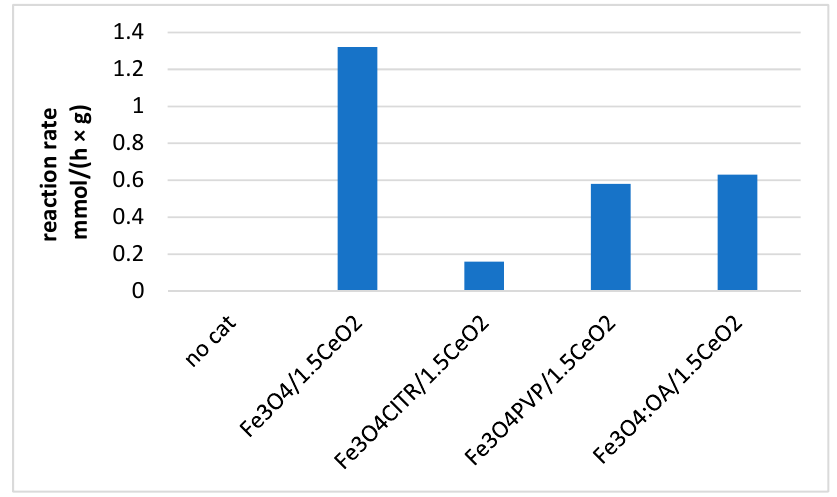
Figure 12. Catalytic activity of various nanocomposites for the imine formation reaction under the conditions reported in Scheme 2.